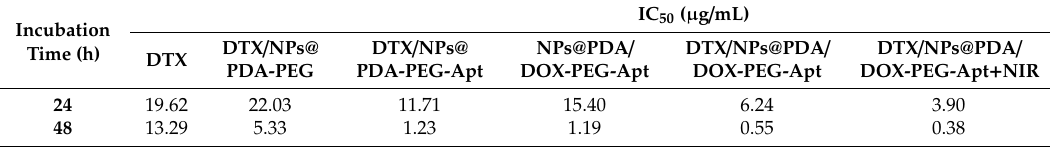
Table 2. IC 50 values on MCF-7 cells after incubation with DTX and DTX-loaded NPs for 24 and 48 h. Incubation Time